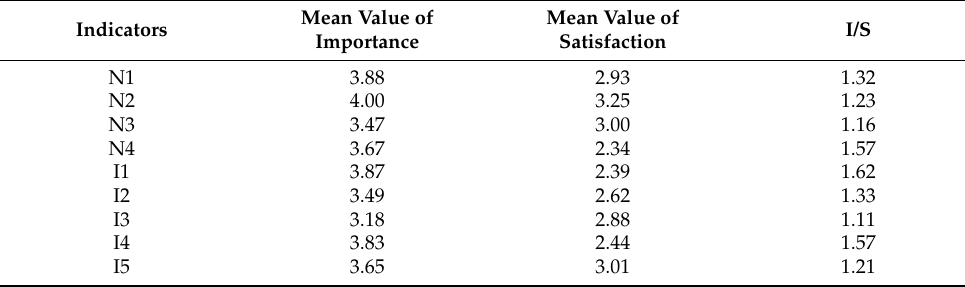
Table 5. Decision sequence of quality